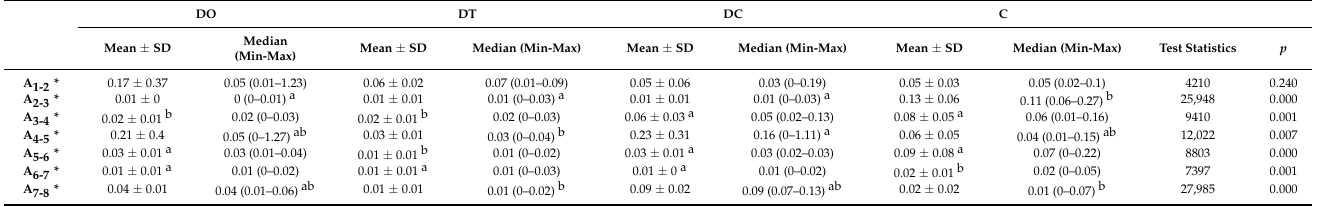
Table 2. Angle deviations of each impression group between adjacent